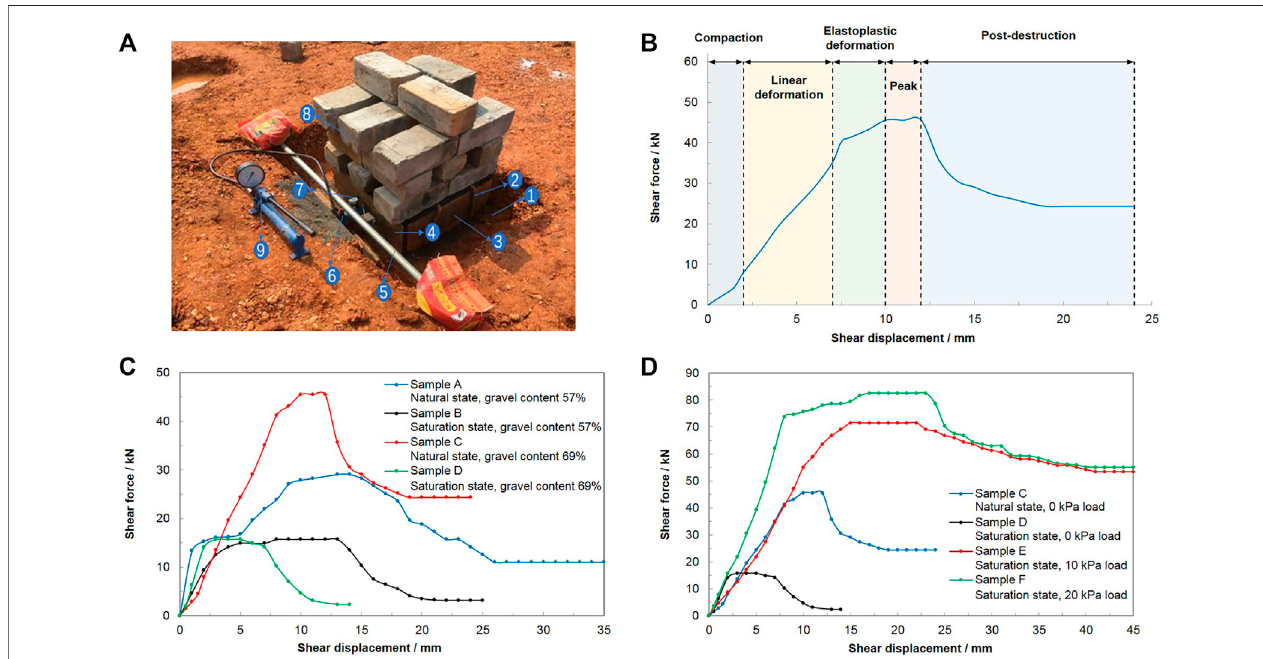
FIGURE 3 | In-situ horizontal push-shear test (A) test device (1-Test pit, 2-Steel drill, 3-Limit steel plate, 4-Thrust steel plate, 5-Reference beam, 6-Horizontal loading jack, 7-Dial indicator, 8-Load, 9-Pressure pump) (B) stages of a typical curve (C) the curves under different gravel contents and water environments (D) the curves under different water environments and overlying